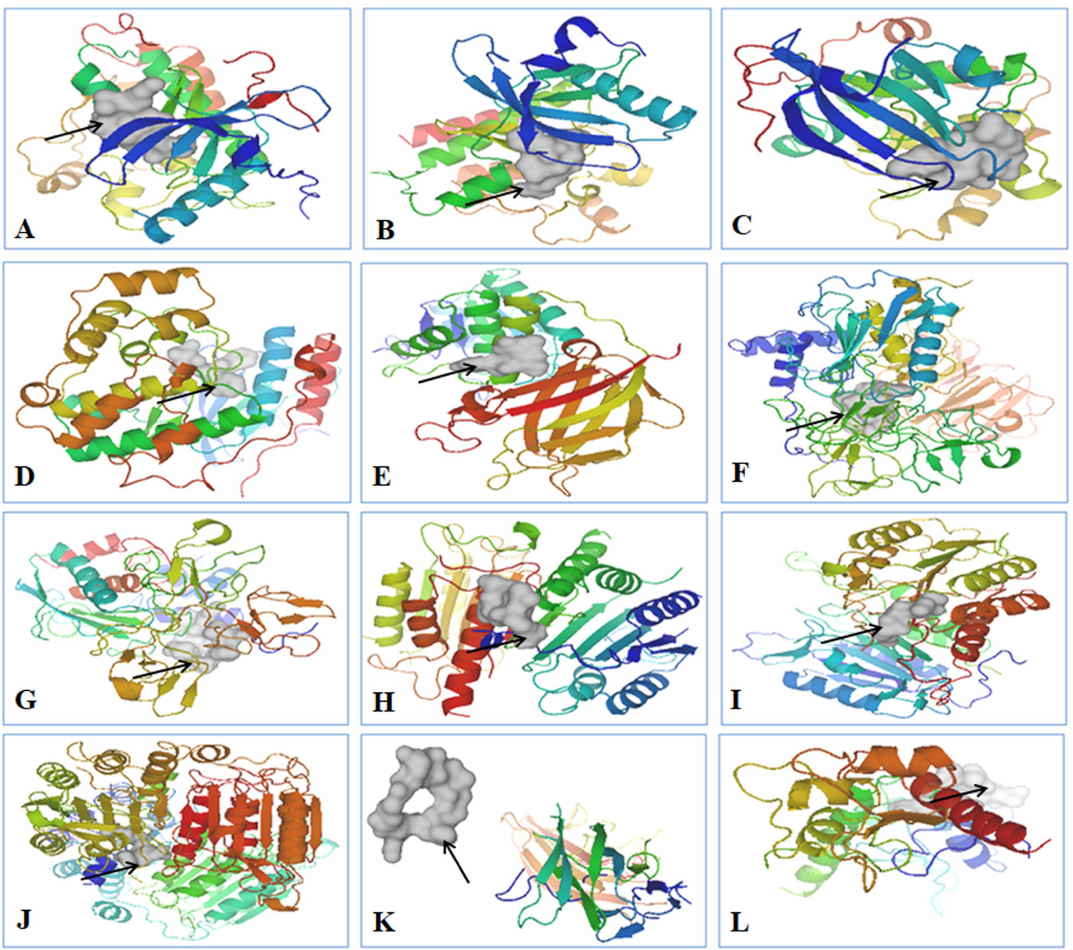
Figure 4. Peptide based ligands bound to specific proteins. Ligands are shown in white, indicated by the arrows, and proteins are depicted in rainbow spectrum. ( A ) CVRACGAD bound to EGFR kinase, ( B ) Cilengitide bound to VEGFR2 kinase, ( C ) RPRTSSF bound to PKB, ( D ) FWCS bound to